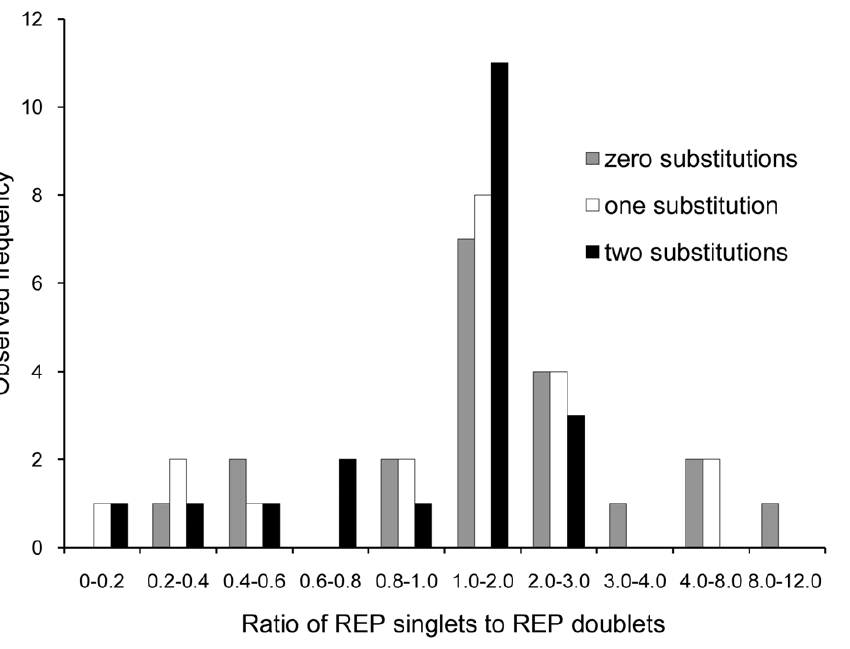
Figure 6. REP singlet to doublet ratios for REP sequences from bacterial genomes. Data are the most abundant 16-mers found within the flanking non-coding DNA of RAYT genes from 18 genomes. In order to include related 16-mers, a set of degenerate sequences was produced by allowing up to two substitutions per 16-mer.